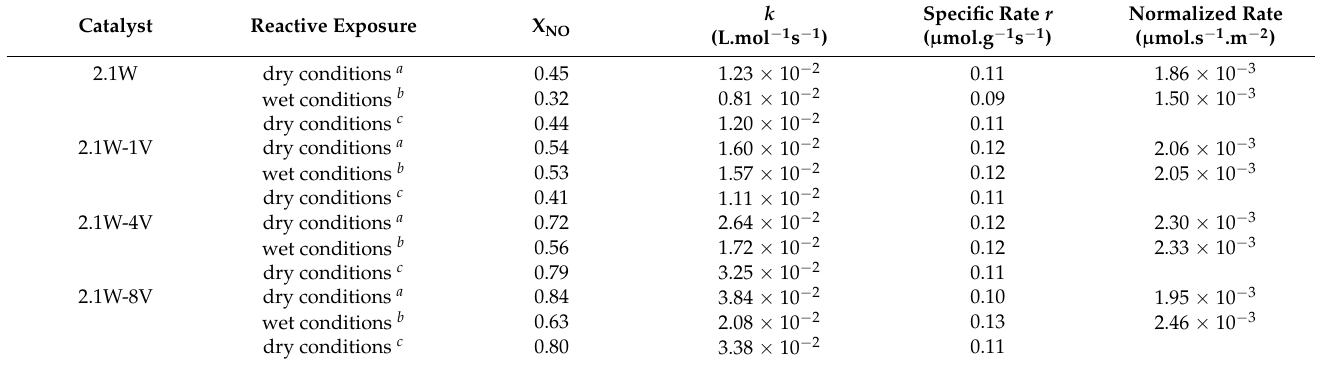
Table 3. Rate measurements during ammonia-SCR on 2.1W- x V catalyst at 160 ◦ C. Catalyst